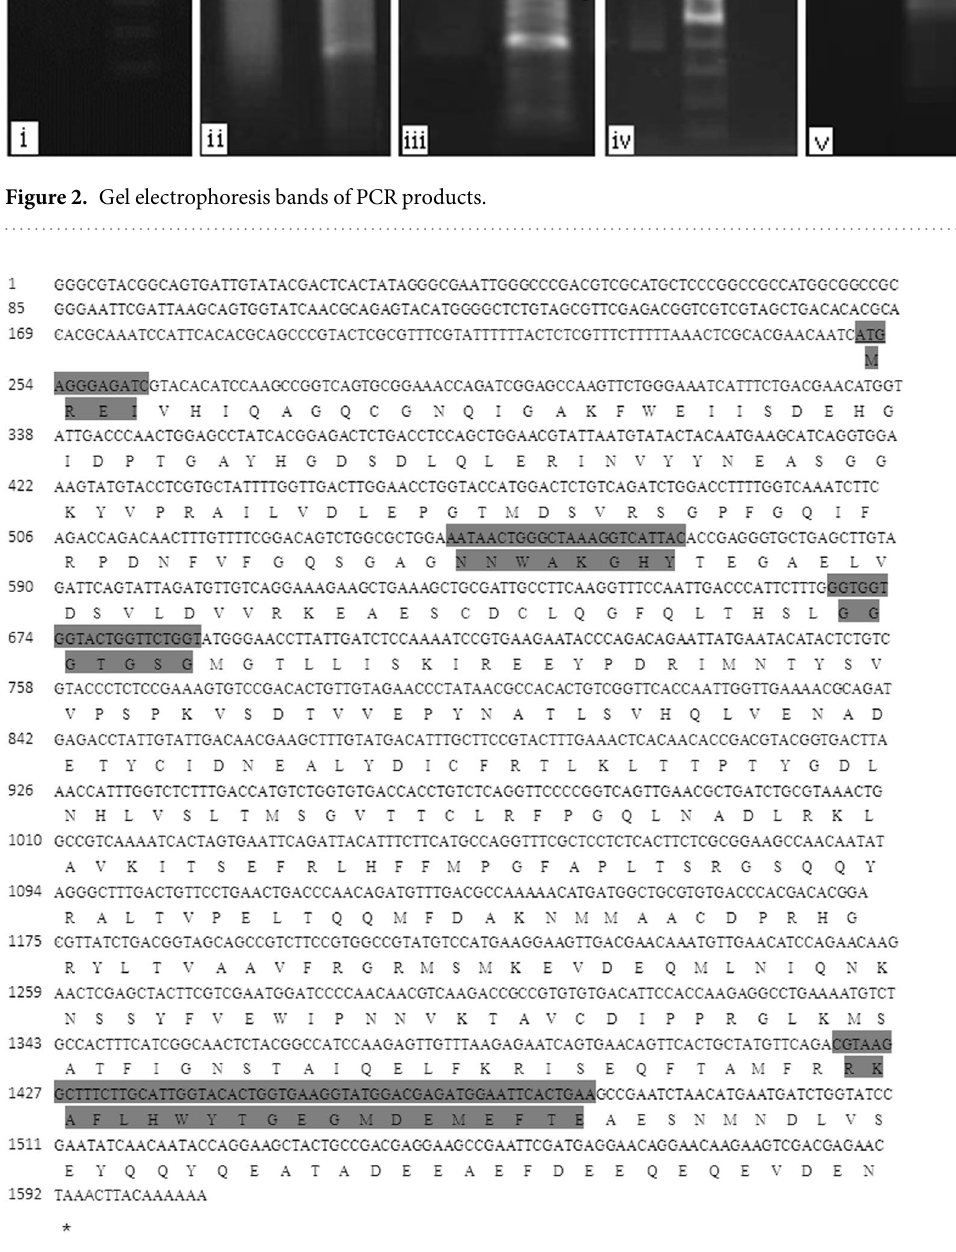
Figure 3. Nucleotide and deduced amino acid sequences of the cloned tubulin